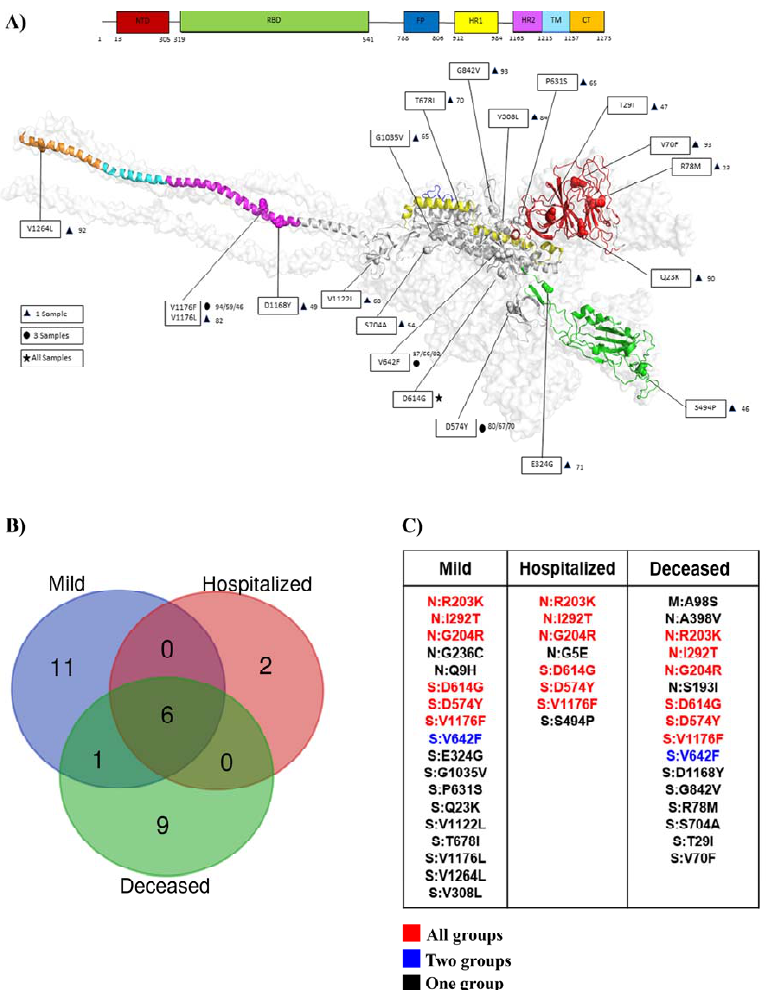
Figure 3. Comparative analyses of SARS-CoV-2 structural mutations in different levels of COVID-19 severity. ( A ) Structural profile of the SARS-CoV-2 spike protein, indicating all mutations identified in Macaé samples after sequencing. ( B ) Venn diagram indicating the correlation of structural mutations found in different levels of COVID-19 severity. ( C ) Table with a detailed description of the mutations in the SARS-CoV-2 structural proteins in different levels of COVID-19 severity. Shared mutations between the three groups are represented in red. Shared mutations between two groups are represented in blue. Exclusive mutations found in only one group are represented in